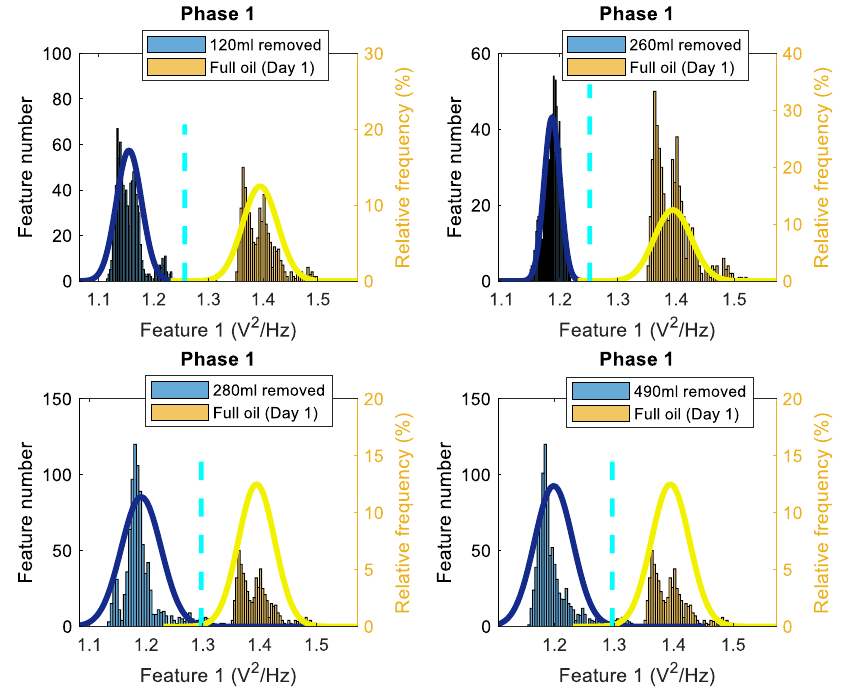
Figure 3. Histograms of Feature 1 (based on the first harmonic of the supply frequency) for phase 1 of the current signals, comparing the standard oil level (Day 1) to 120 mL, 260 mL, 280 mL and 490 mL of the removed oil cases (the solid lines are the PDF, and the dashed lines are thresholds).